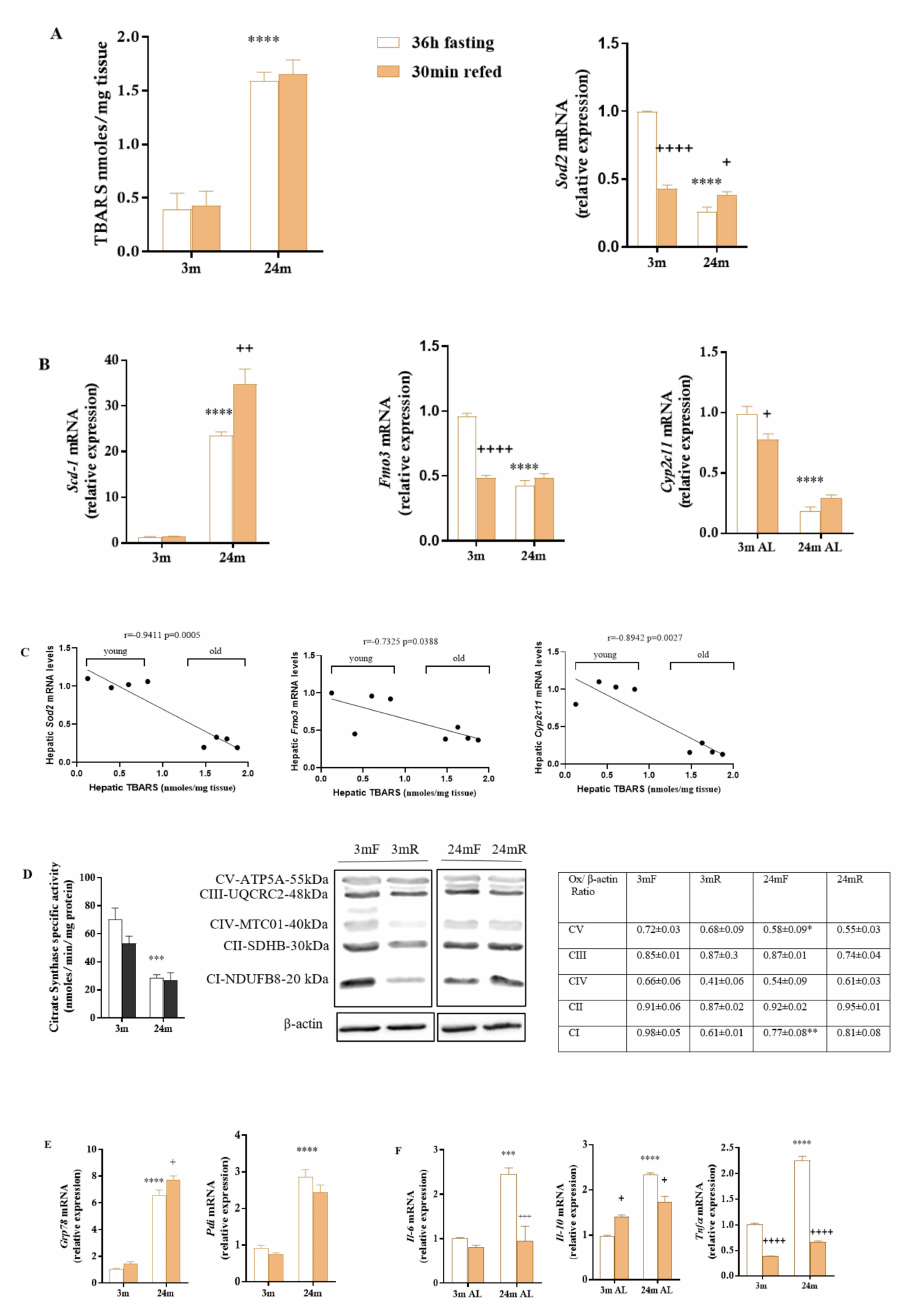
Figure 1. Thiobarbituric acid reactive substance (TBARS) levels and mRNA levels of the antioxidant gene Sod2 ( A ), mRNA levels of the oxidoreductase genes Scd1 , Fmo3 , and Cyp2c11 c ( B ), correlation analysis between TBARS levels and Sod2 , Fmo3 and Cyp2c11 mRNA levels in Wistar rat after prolonged fasting ( C ), hepatic citrate synthase activity and OXPHOS protein complex levels ( D ), mRNA levels of genes implicated in ER stress ( Grp78 and Pdi ) ( E ), and the mRNA levels of the proinflammatory ( Il-6 and Tnf α ) and anti-inflammatory ( Il-10 ) cytokines ( F ), in the liver of Wistar rats during a fasting-refeeding cycle. Values are expressed as means ± SEM of 4 animals. Data were analyzed by two-way ANOVA followed by Tukey’s correction. Correlation analysis was determined by Pearson’s correlation coefficient test (r). Two-way ANOVA was performed to detect main effects of age, fasting-refeeding, and age fasting-refeeding interaction. *** p < 0.001, **** p < 0.0001 vs. the young rats. + p < 0.05, ++ p < 0.01, +++ p < 0.001, ++++ p < 0.0001 vs. the age-matched fasted rats. Two-way ANOVA indicate a significant effect of age on Grp78 ( p < 0.0001; F = 305.4; Df = 1) and Pdi ( p < 0.0001; F = 13.26; Df = 1). Two-way ANOVA indicated a significant interaction between fasting-refeeding and age for Sod2 ( p < 0.0001; F = 185.8; Df =1); Scd-1 ( p < 0.0078; F = 10.15; Df = 1); Fmo3 ( p < 0.0001; F = 71.68; Df = 1); Cyp2c11 ( p = 0.0041; F = 12.53; Df = 1); Il-6 ( p < 0.0035; F = 13.11; Df = 1); Il-10 ( p < 0.0001; F = 83.02; Df = 1) and Tnf α ( p < 0.0001; F = 136.6; Df =